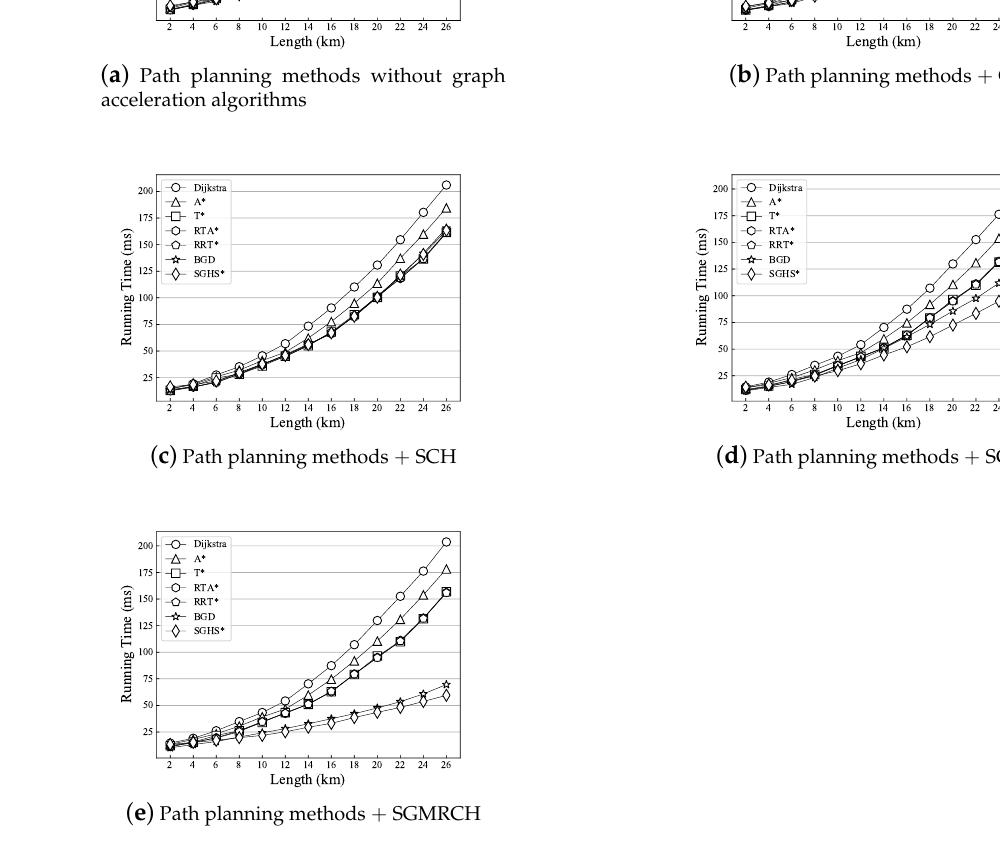
Figure 16. Comparison of running efficiency of algorithms combined with different graph contraction algorithms based on different length